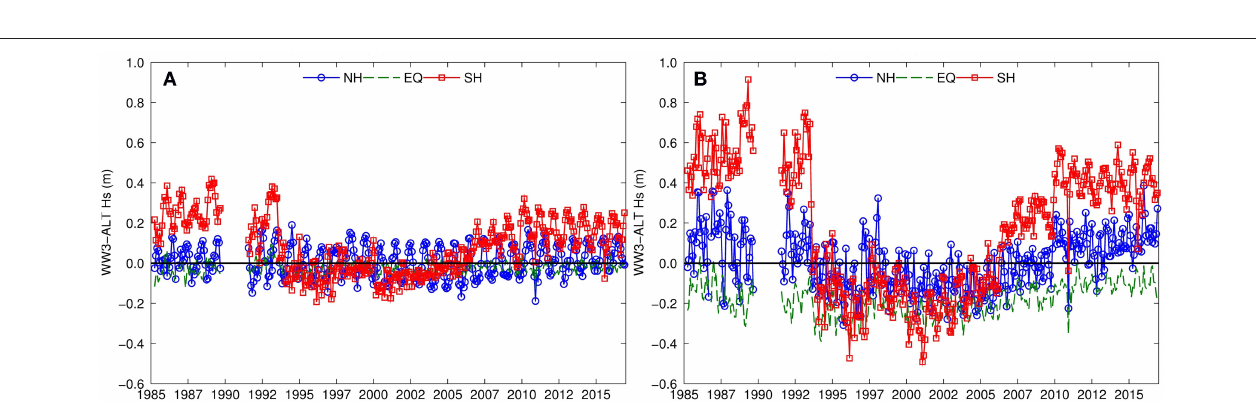
FIGURE 4 | H s trends computed from a monthly time series of the 99th percentile from the merged altimeter database of Zieger et al. (2009) in 2 ◦ bins. The black stippling represents a statistically significant trend at the 99% confidence limit. reprinted from Young et al. (2011), as authorized by AAAS.